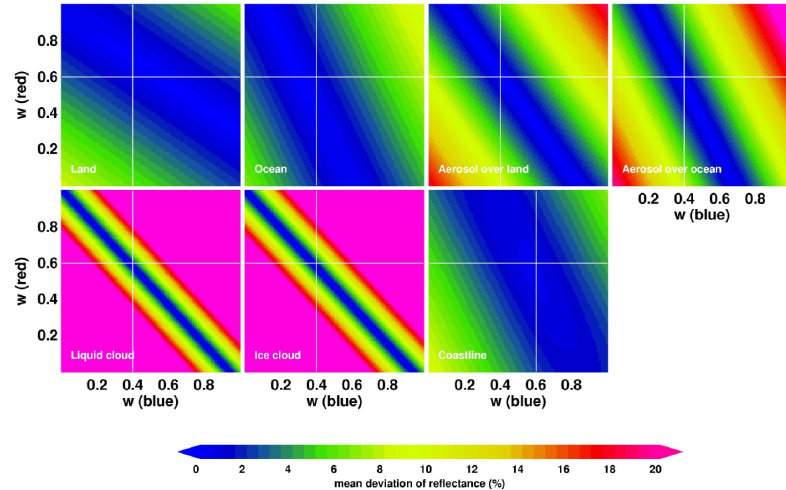
Simulation of GOES-R ABI aerosol radiance